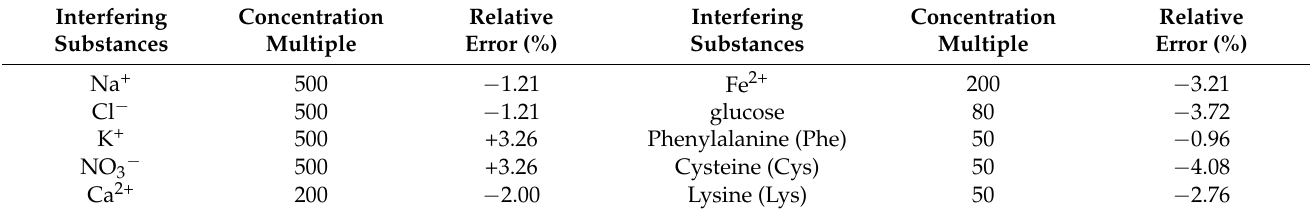
Table 1. Effects of Different Interfering Substances on NOR Detection by MIP/TBC/GCE Sensors.